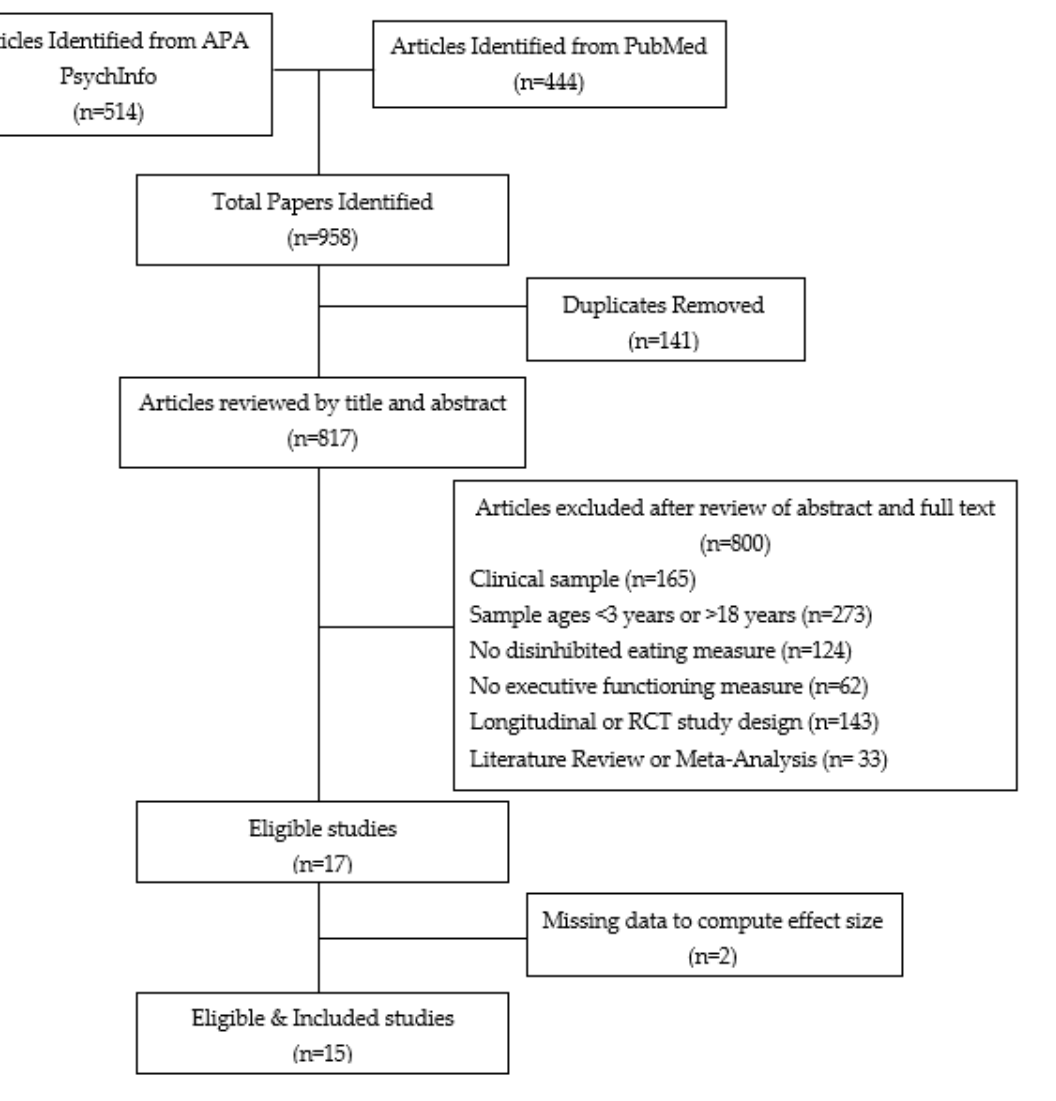
Figure 1. Consort flow diagram.